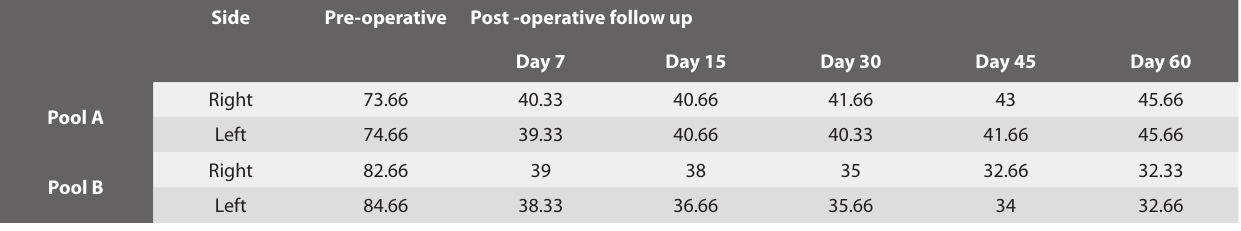
Table 2. Mean of inferior turbinate size (in % of internal nasal valve area). Side Pre-operative Post -operative follow